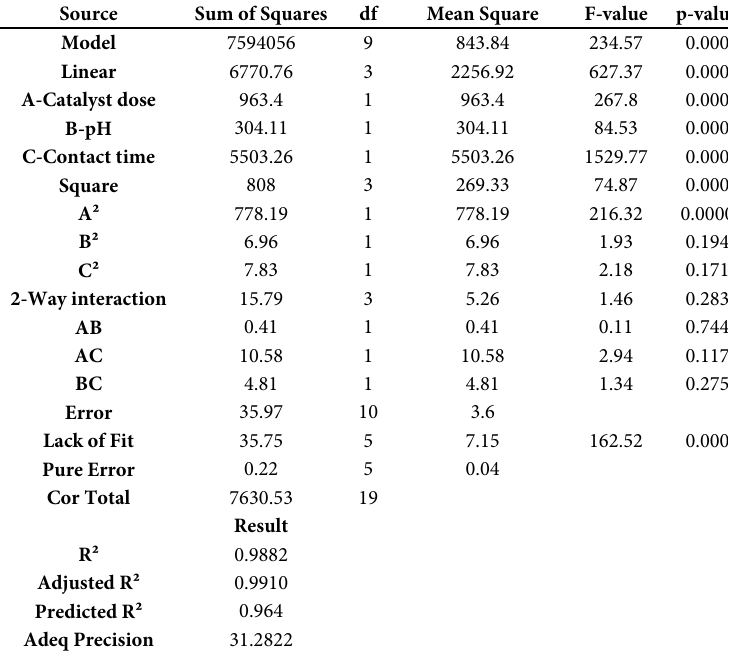
Table 5. ANOVA results in the removal of AR 18 by the photocatalytic